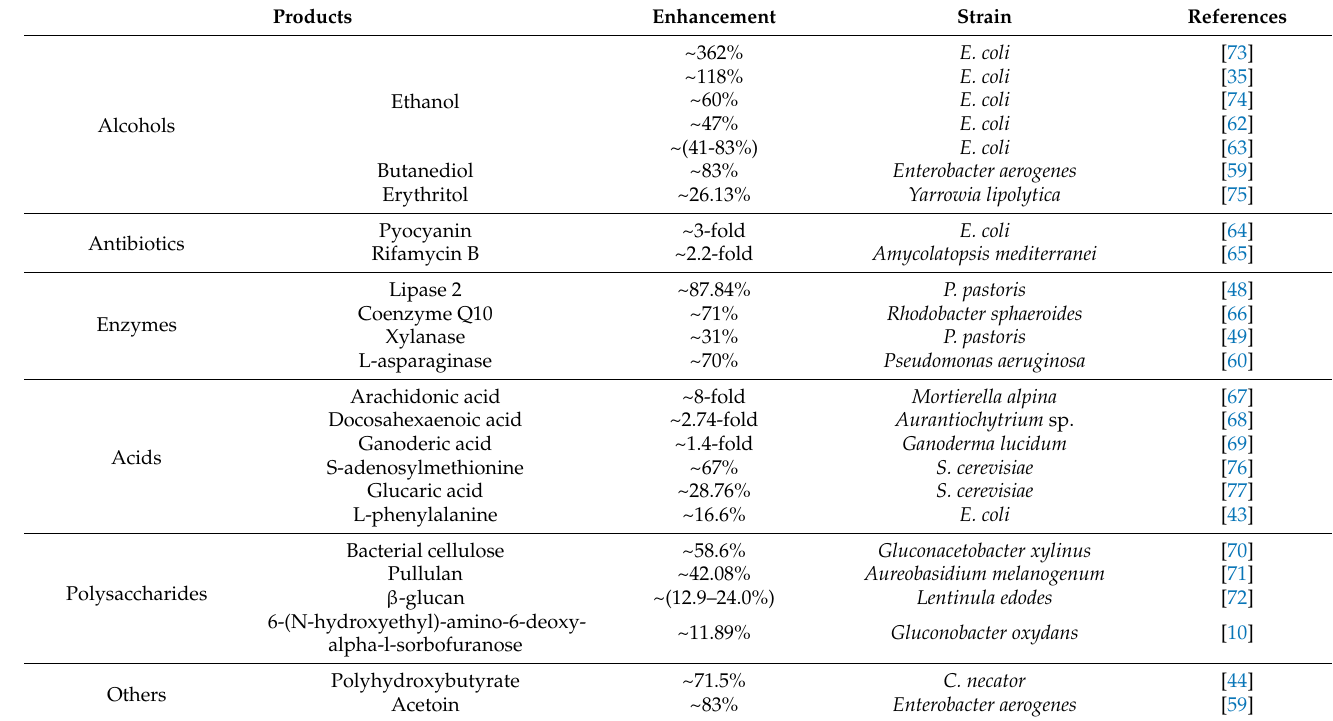
Table 3. The titer of products increased by the expression of